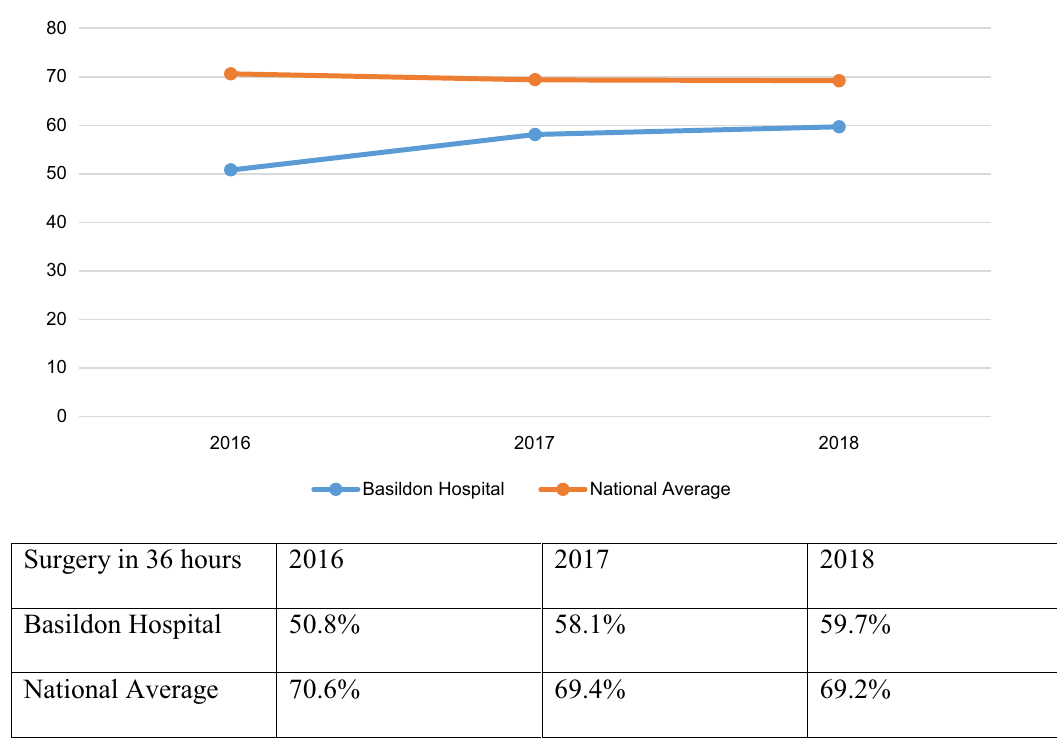
Figure 2. Surgery within 36 h (% of